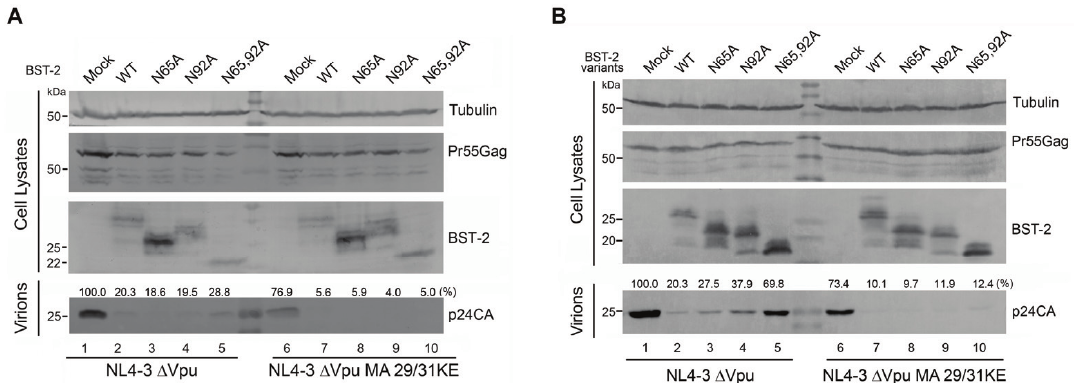
Figure 3. N-linked glycosylation of human BST-2 is dispensable for intracellular MVB-targeted HIV-1 inhibition. ( A ) 293T cells stably expressing BST-2 or its variants in six-well plates were transfected with 1 µ g of pNL4-3 ∆ Vpu or pNL4-3 ∆ Vpu MA 29/31KE proviral plasmids. After 48 h, cultured supernatants were ultracentrifuged to concentrate the virion particles. Virions and cell lysates were analyzed by Western blotting to detect viral p24CA and intracellular Pr55Gag proteins; ( B ) 293T cells in six-well plates were transfected with 1 µ g of pNL4-3 ∆ Vpu or pNL4-3 ∆ Vpu MA 29/31KE proviral plasmids and 50 ng of BST-2 variants. After 48 h, cultured supernatants were ultracentrifuged to concentrate the virion particles. Virions and cell lysates were analyzed by Western blotting to detect viral p24CA and intracellular Pr55Gag proteins.